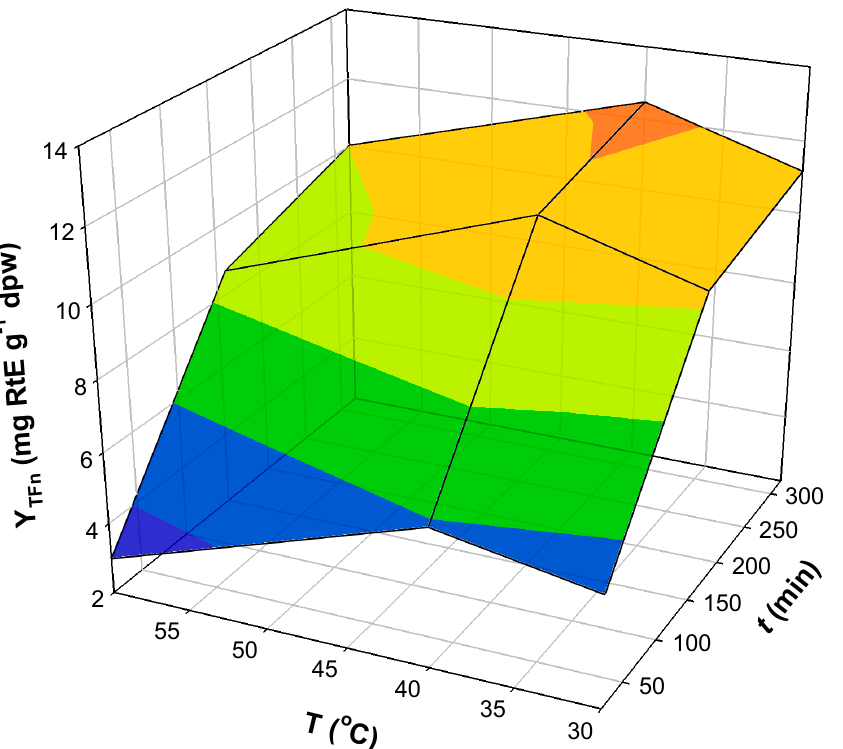
Figure 4. Three-dimensional plot illustrating the Y TFn tendency of RGP extraction with 0.5% ( w / v ) aqueous LA, as a function of t and T